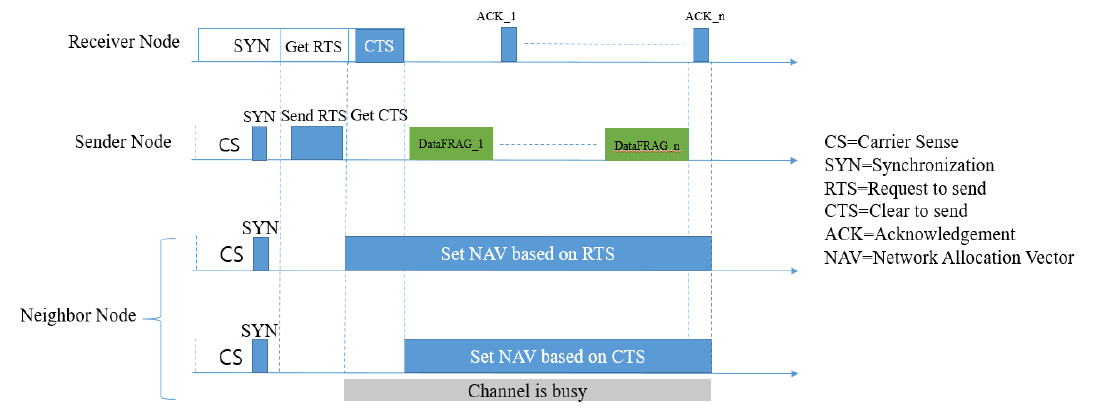
Figure 4. Packet transmission using S-MAC [1].